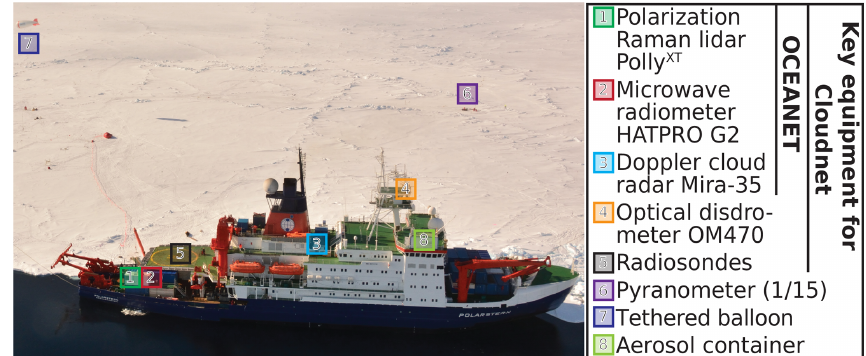
Figure 2. Polarstern during the ice floe camp performed during the PASCAL campaign. Annotated are the locations of some selected instruments for atmospheric measurements. The labels (1)–(5) indicate the positions of the key instruments used for Cloudnet processing: Polly XT , HATPRO, Mira-35, disdrometer, and radiosondes. The label (6) denotes one of the 15 pyranometers comprising pyranometer network; label (7) is the tethered balloon launching site, and at (8) aerosol in situ measurements were conducted. Equipment items (1)–(3) are a permanent part of OCEANET. Picture by Niels